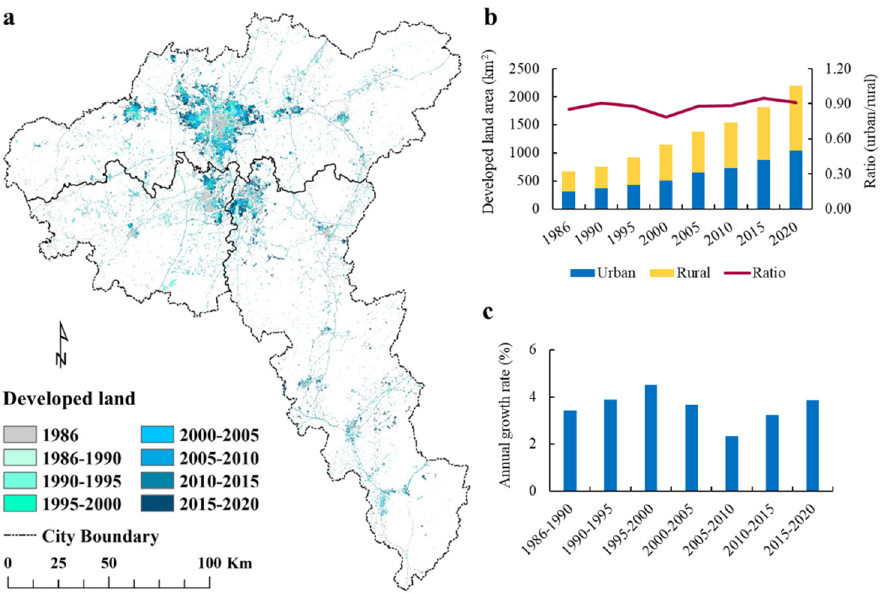
Table 1. Urban and rural differences in developed land changes from 1986 to 2020.